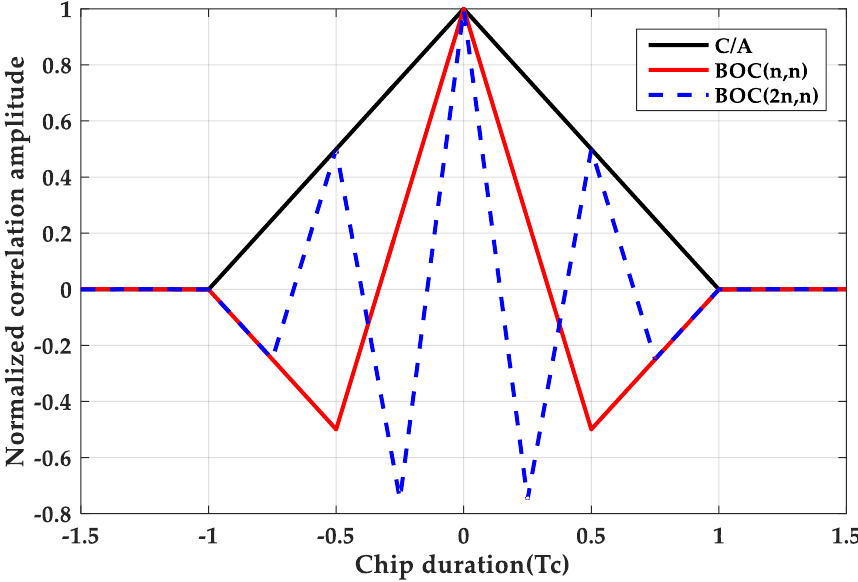
Figure 1. Auto-correlation function.